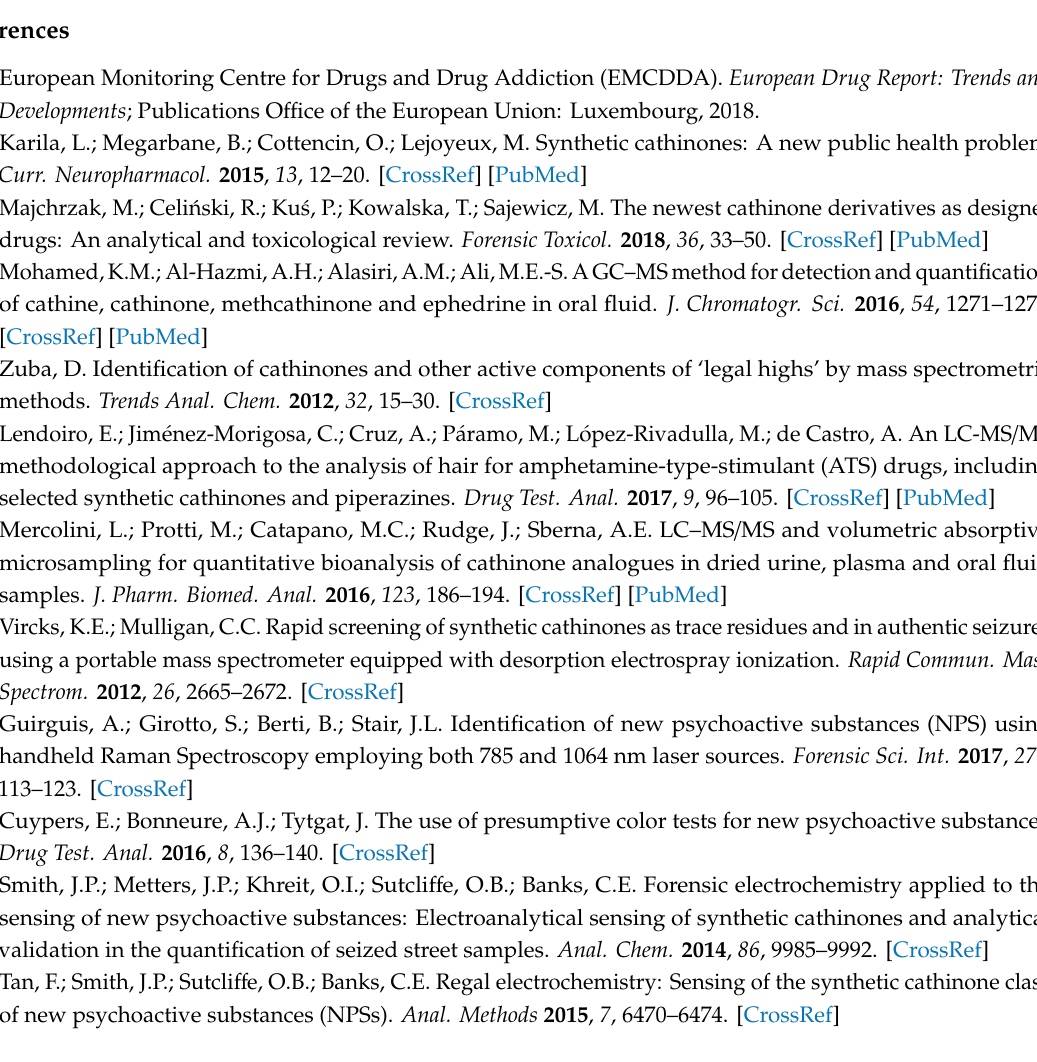
Figure S3: Stability of BSA-Au NCs with di ff erent pH values over time, Table S1: Structures of cathinone-drugs and other tested